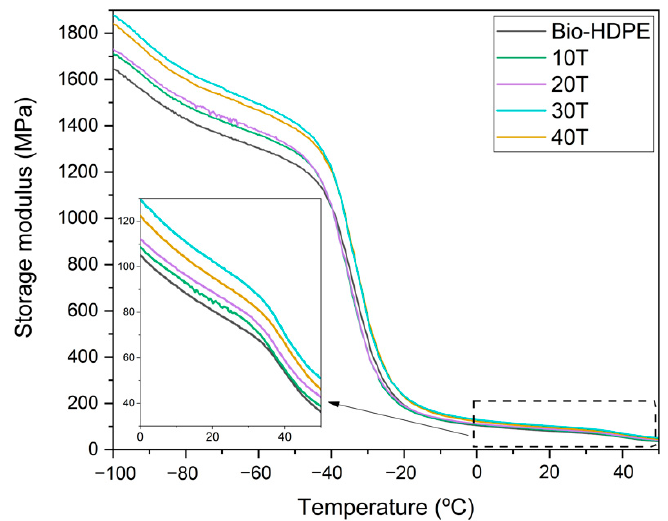
Figure 9. Evolution of storage modulus (G’) in bio-based high-density polyethylene (Bio-HDPE) with different weight percentage of treated chia seed flour with APS.